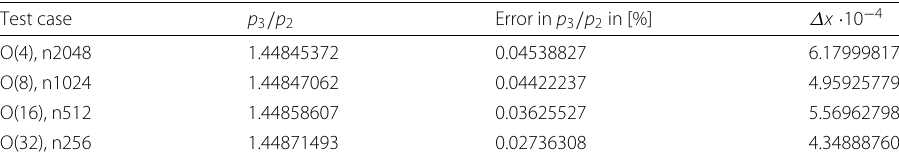
Table2 Comparison of simulation results with the exact solution Test